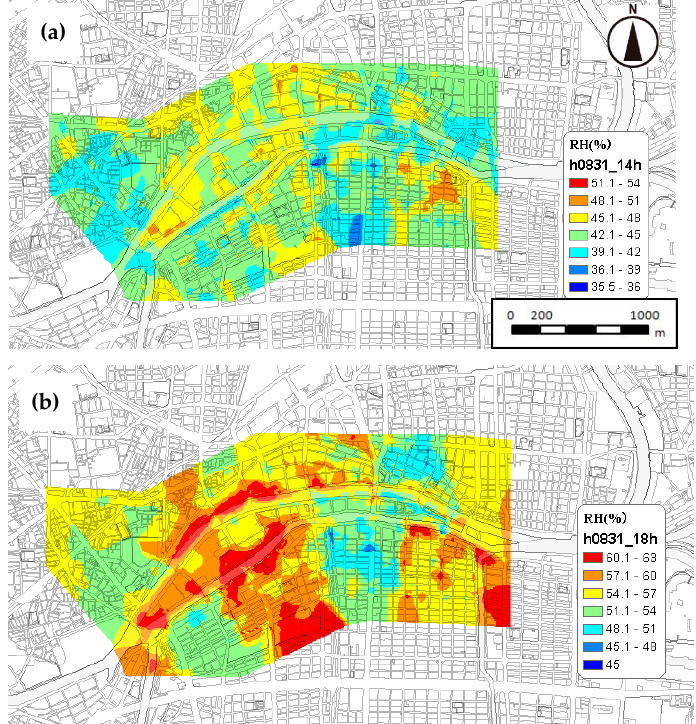
Figure 8. Relationships between ( a ) gross building coverage ratio (GBC) and deviation of mean temperature (DT), ( b ) the mean number of stories (S) and DT, ( c ) GBC and standard deviation of temperature in a subarea ( σ T ), and ( d ) S and σ T . The symbols in a box of thick line are the data within the Nakanoshima district (subarea 7 and 8). **: p < 0.01, *: p < 0.05.